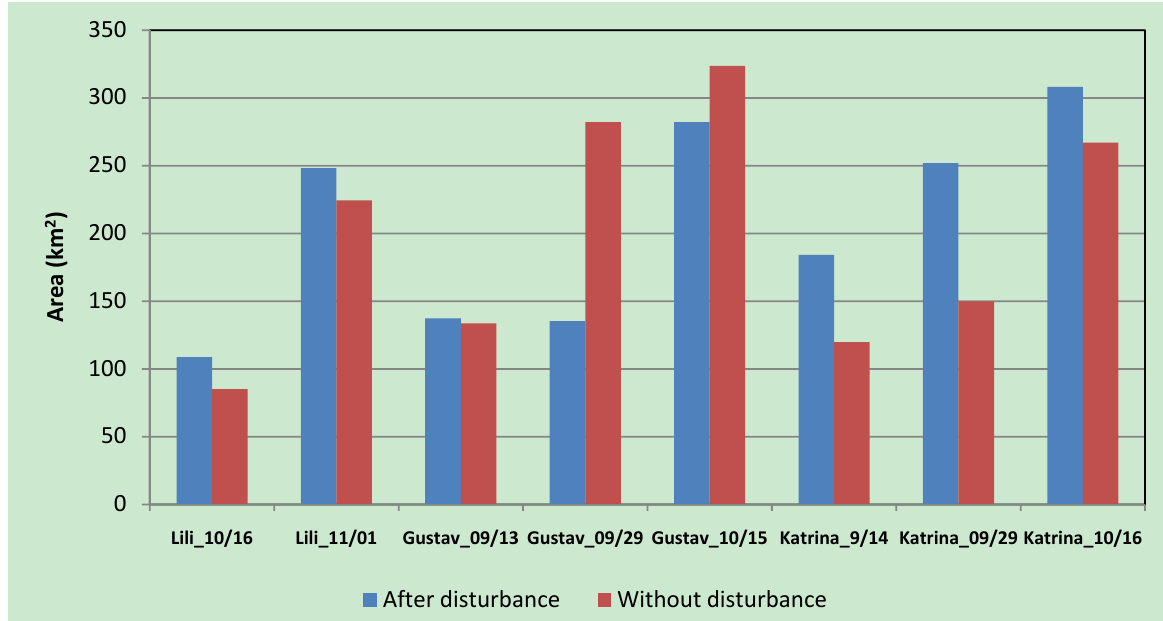
Figure 6. Area of vegetation with greater than 45% decrease of the EVI values from pre- to post-hurricane events in the entire